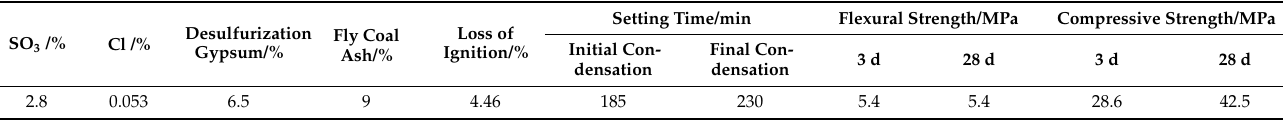
Table 1. Physical and mechanical properties of cement index.